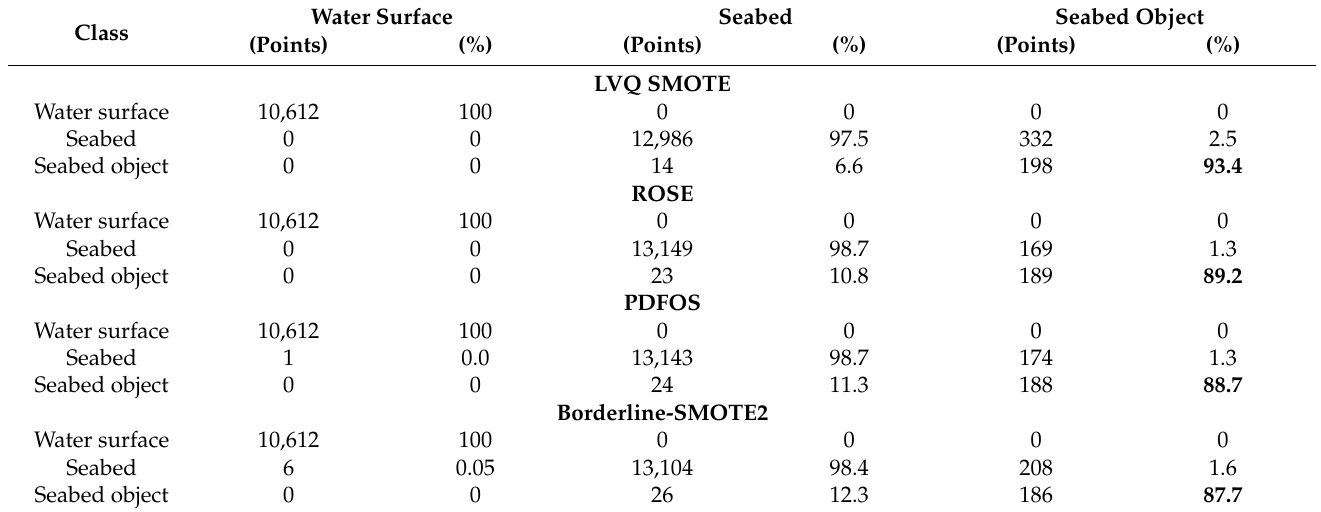
Table 5. Confusion matrix of the four algorithms with best object detection.